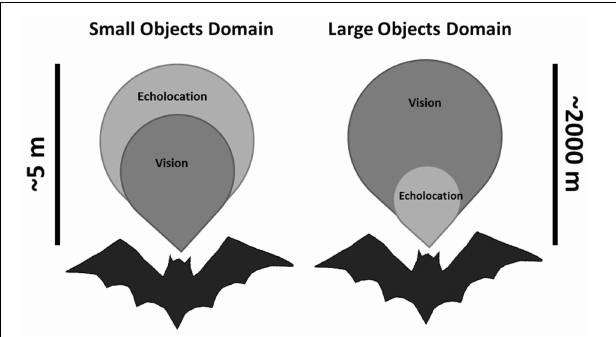
FIGURE 4 | Sketch depicting the two sensory domains used by echolocating bats that are flying in intermediate light levels. Left—echolocation is slightly advantageous when searching for small prey. Right—Vision is strongly advantageous when avoiding large obstacles. Scale bars depict the approximated detection distances, but are qualitative and not quantitative (especially for the large objects